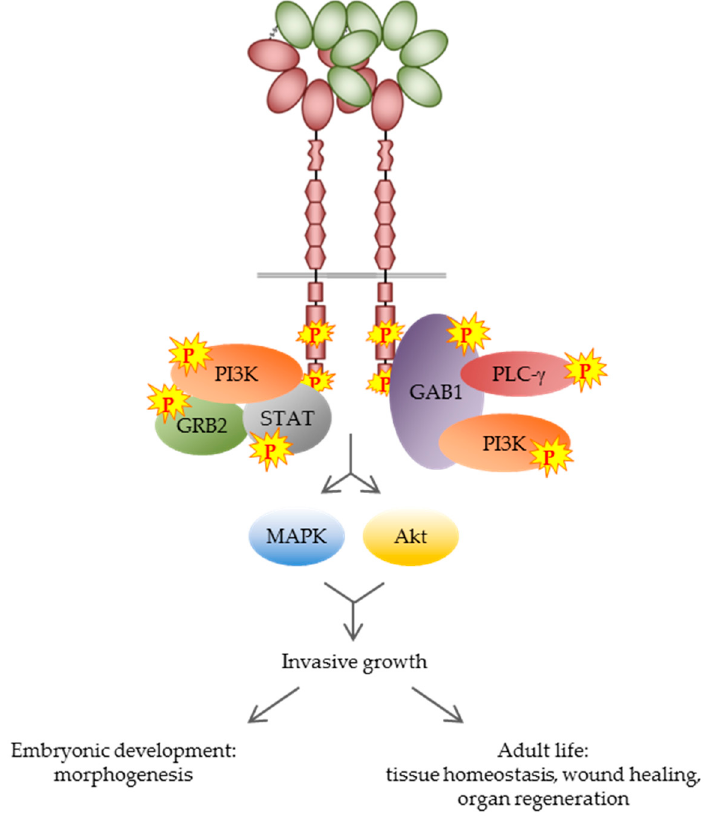
Figure 2. MET signaling in the physiological context. Upon MET activation, signal-relay molecules are recruited to the receptor, resulting in activation of the MAPK (mitogen-activated protein kinase)/Akt signaling pathways. This process controls the genetic program known as ‘invasive growth’ that in the physiological context plays a pivotal role in embryogenesis and in tissue homeostasis during adult life. PI3K, phosphoinositide 3-kinase; GRB2, growth factor receptor-bound protein 2; STAT, signal transducer and activator of transcription protein; GAB1, GRB2-associated-binding protein 1; PLC- ϒ , phospholipase C ϒ 1 In the early phases of mouse embryogenesis, HGF and its receptor MET are co-expressed in endodermal and mesodermal structures along the rostro-caudal axis [35]. However, during organogenesis, autocrine signaling stops in favor of a paracrine mode of activation, in which MET, expressed by epithelial and myoblast progenitors, is stimulated by the HGF produced by mesenchymal cells [36]. This paracrine loop is able to conjugate proliferative and anti-apoptotic